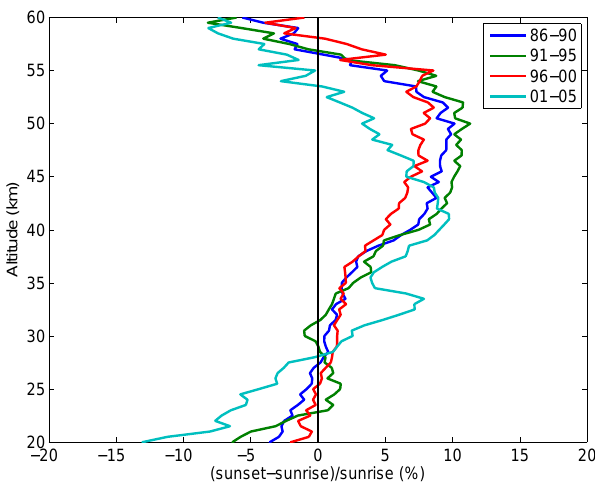
Fig. 4. The SAGE II ozone median of sunrise measurements com- pared to the median of sunset measurements for 5yr periods in the tropics (10 ◦ S–10 ◦